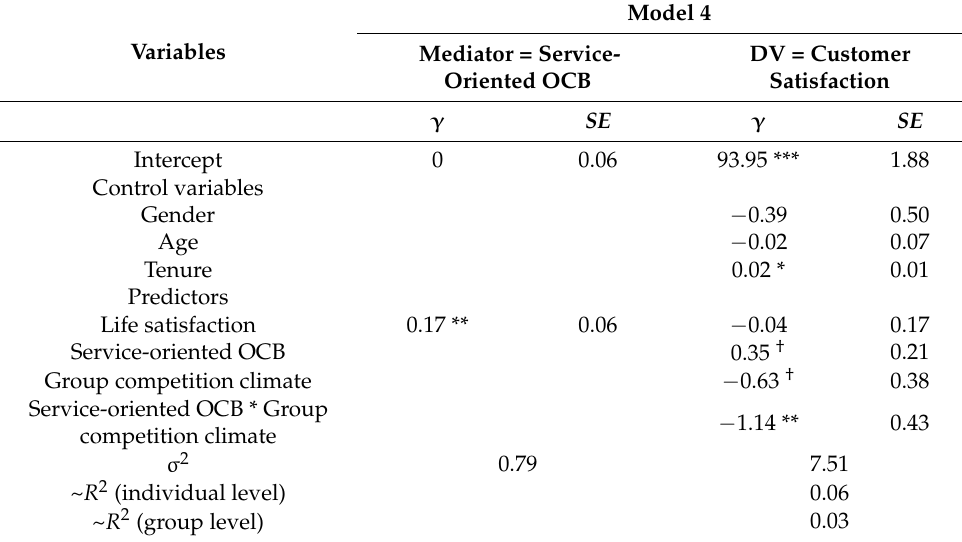
Table 4. Multilevel Analysis Results for Testing Hypothesis 4.